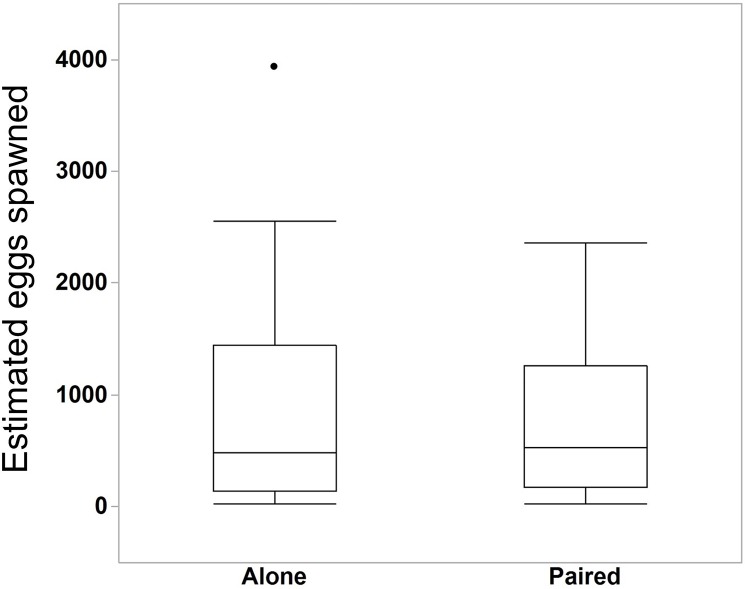
Estimated number of eggs in bowls of individuals that spawned alone (N = 30 bowls) and in pairs (N = 25 bowls).Surprisingly, two M. leidyi spawning together did not produce more eggs than individuals spawning alone (Student’s t-test, t-ratio = 0.005, p = 1.0). The data point above the “Alone” box plot indicates an individual that spawned an estimated 3,934 eggs. Removing this data point did not change the overall findings of the analysis.